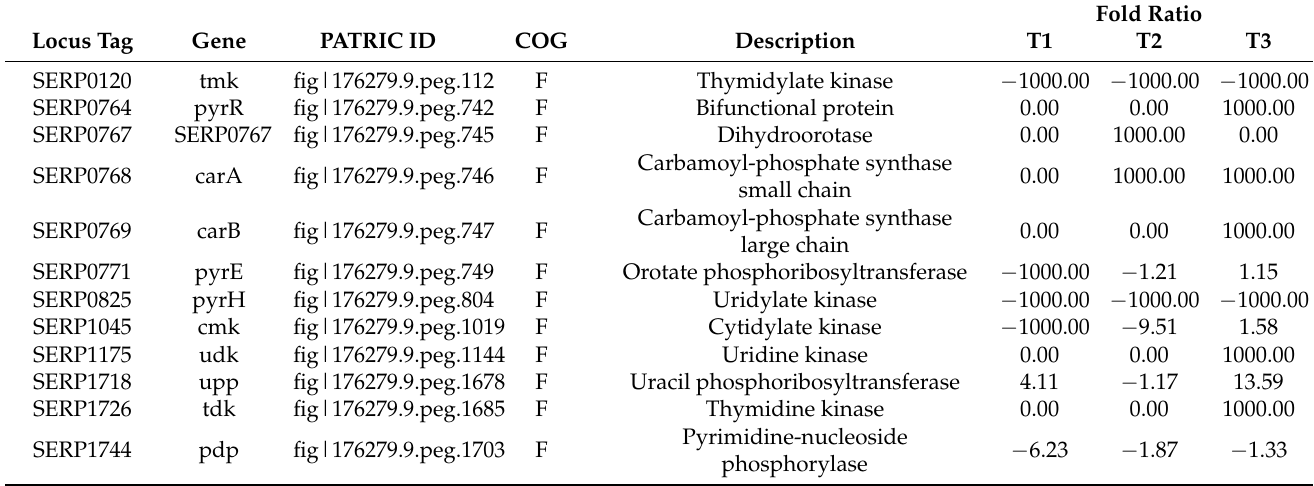
Table 8. Differentially expressed proteins associated with pyrimidine metabolism.